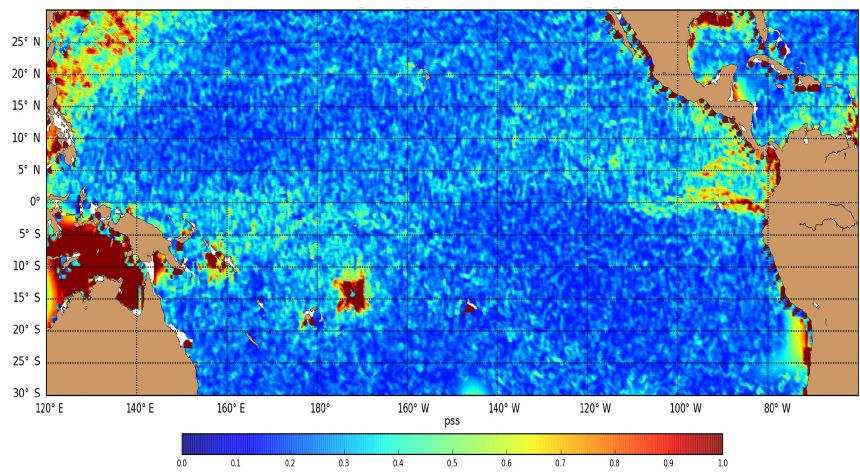
r 4 r 3 r 2 r 1 on a 3 ◦ × 3 ◦ grid (see Eq. 4) estimated and applied to the a priori ξ ξ ξ ξ ξ